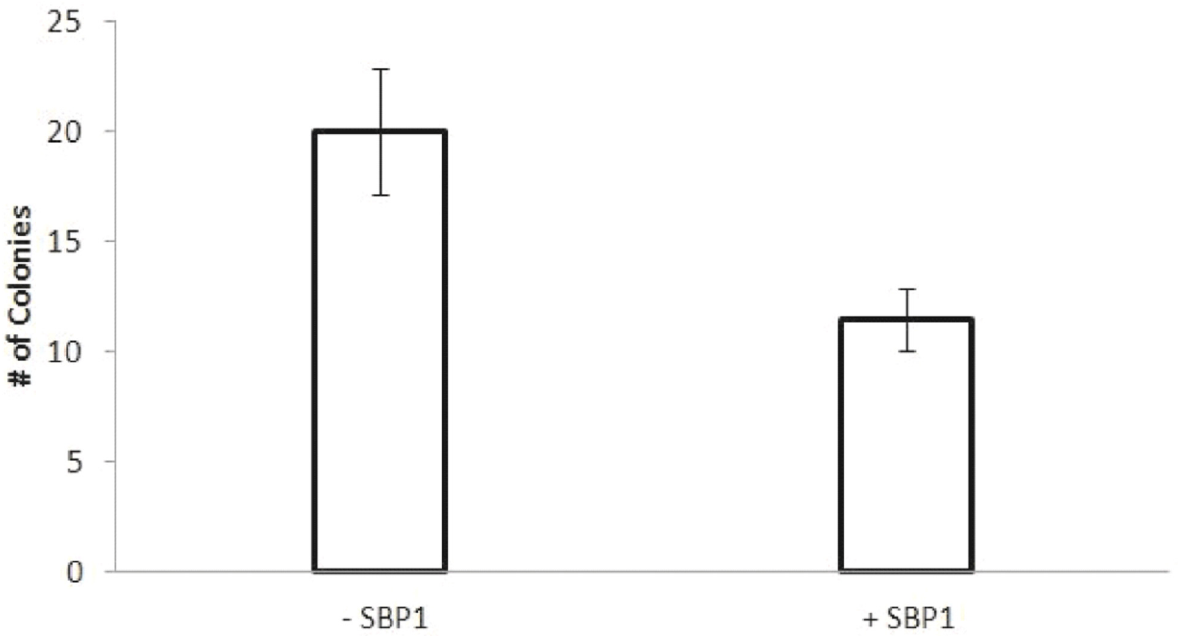
Fig 5. SBP1 decreases soft agar colony formation in HCT116 cells. The ability of HCT116 cells with and without SBP1 to form colonies in soft agar was measured. Cells induced to express SBP1 as well as SBP1-null cells were mixed with media containing 0.4% agarose, and each group was plated in triplicate on 6 well plates coated with 0.6% agarose in media. Each well contained 5x10 4 cells, and colonies larger than 0.5mm were counted on day 15 of growth (A). Error bars represent S.D. ( * p < 0.05 n = 3).